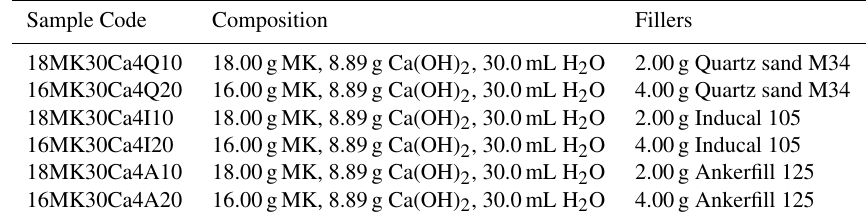
Table 2. Sample codes of Batch 2 with Ca(OH) 2 de as activator and different